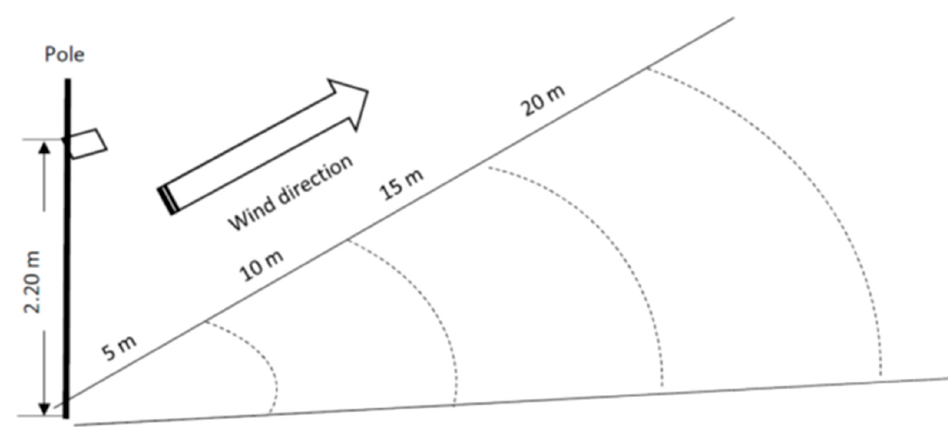
Figure 2. Seed dispersal experimental set-up. Dehisced fruit was secured at the platform on the pole. There were 11 dispersal bins at 5 m intervals, making a threshold of 55 m.